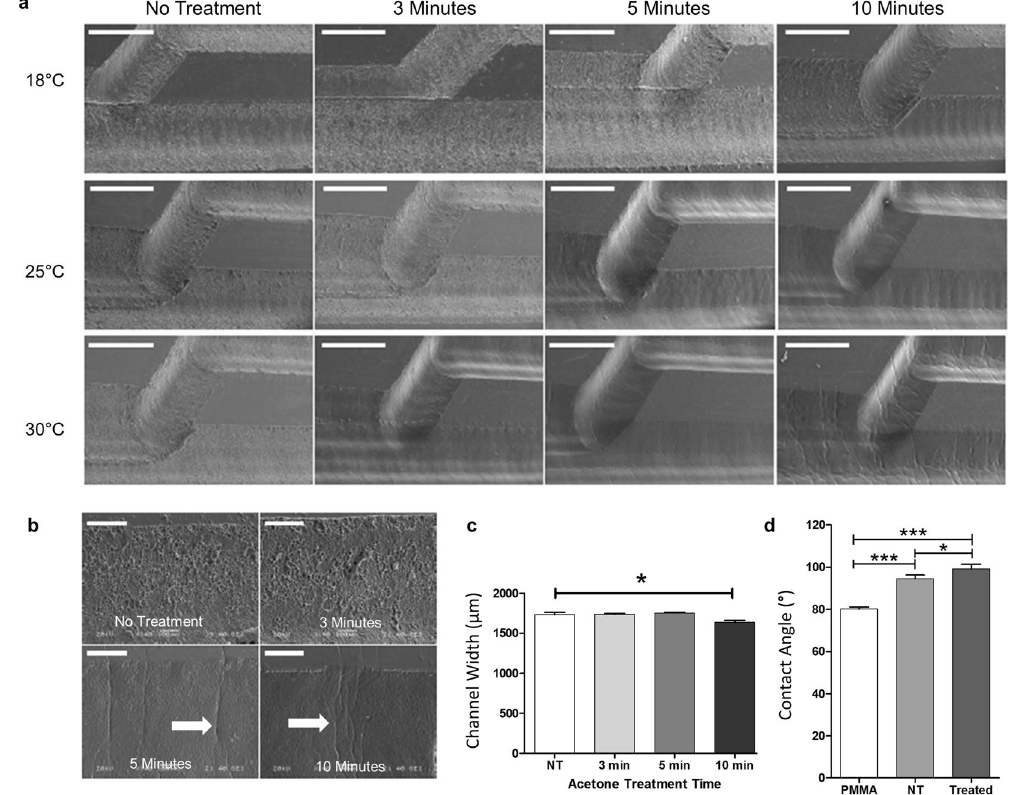
Figure 4. Surface treatment of engraved channels. ( a ) Scanning electron microscopy of channel surface for PMMA laser-machined devices treated with acetone vapor for 3, 5 and 10 minutes at 18 °C, 25 °C or 30 °C, followed by thermal treatment at 70 °C for 20 minutes, as compared to samples with no treatment. Scanning electron micrographs reveal changes in the surface roughness and presence of microcavities and other defects. Scale bar: 1000 μ m. ( b ) Detail of channel walls after acetone vapour exposure for 3, 5 and 10 minutes at 25 °C. Cracks can be observed on the surface (white arrow). Scale bar: 200 μ m. ( c ) Changes in channel width after exposure to acetone vapour at 25 °C for different times followed by thermal treatment (20 minutes, 70 °C for all samples). Channel width was analysed from scanning electron micrographs. Data analysed by one-way ANOVA (mean ± s.e.m, n = 3, * p < 0.05). ( d ) Contact angle measurements for bare PMMA, and laser-cut PMMA without treatment (NT) and after acetone-assisted thermal treatment. ( * p < 0.05, *** p < 0.001). Data analysed by one-way ANOVA (mean ± SD, n = 3) with Tukey post-hoc